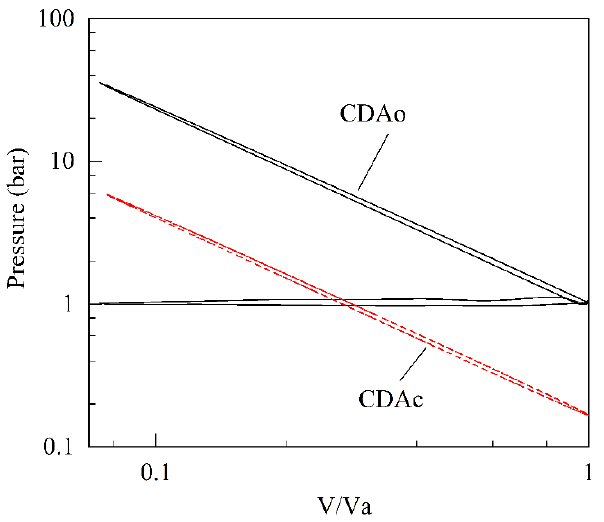
Figure 10. The normalized P-V diagram in the deactivated cylinder under the CDAo mode and CDAc mode (the calculated results were obtained from 1D simulation of GT-SUITE).